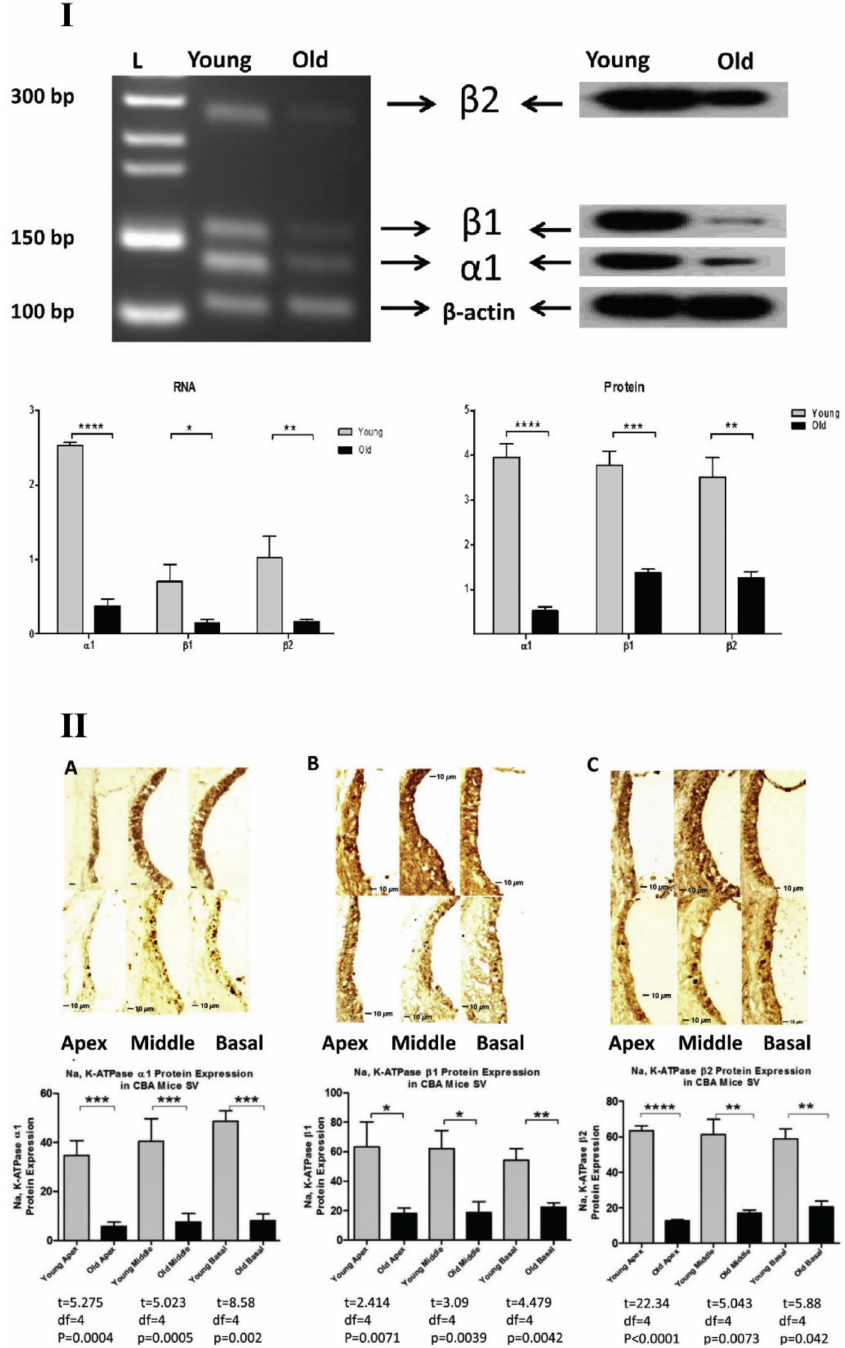
Figure 4. Age-related decrease in Na, K-ATPase subunits in CBA/CaJ mouse cochlea . ( I ) Protein lysate and mRNA extracts were analyzed for young adult (3 months) and old (30 months) CBA/CaJ mice using western blotting and RT- PCR techniques, respectively. There was significant decrease in α 1, β 1, β 2 subunits of Na, K-ATPase at both protein and gene expression levels. ( II ) Cross sections of cochlea with immunostaining further confirmed the results using immunohistochemistry i.e., there was a significant decrease for Na, K-ATPase subunits α 1, β 1, β 2 with aging in all three cochlear turns. * p < 0.05, ** p < 0.01, *** p < 0.005, **** p < 0.001. From Ding et al. (2018) [121], with permission from the